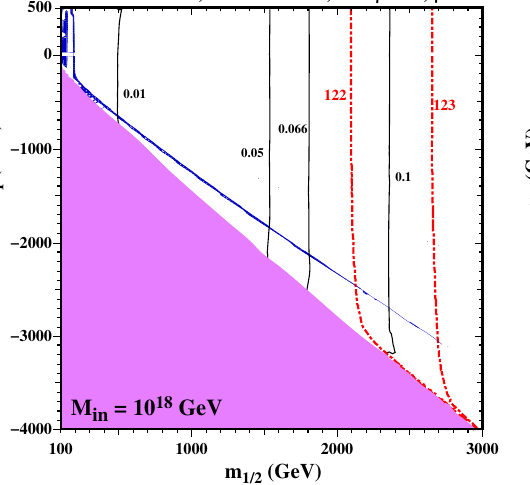
Fig. 5 Examples of ( m 1 / 2 , m 1 ) planes for M in = 10 18 GeV when only H is twisted. In the left panel , the modular weights are α t = 0, α b = 1, α λ = 1, α λ (cid:2) = 0, β = 1 and β (cid:3) = 0, so that all trilinear and bilinear H terms vanish. In the right panel , all the weights vanish, so that A t = 0,